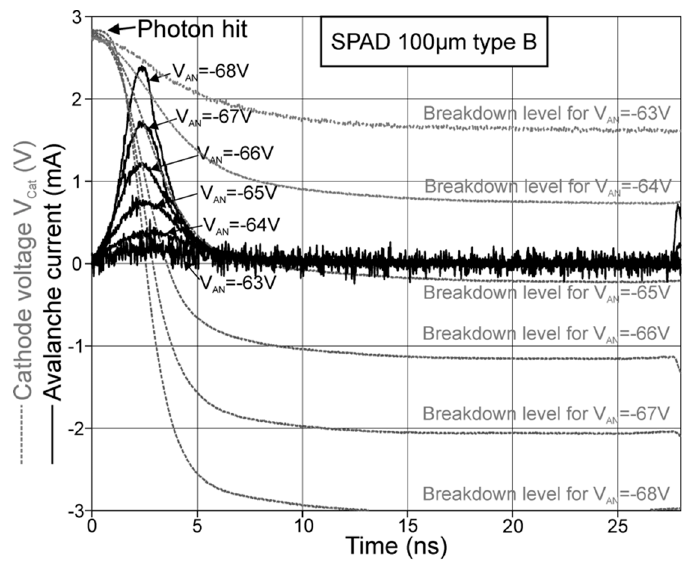
Figure 9. Avalanche-current transients for a SPAD type B with 98.2 µm diameter for different anode voltages V AN , where the avalanche starts at 0 ns. Micromachines 2020 , 11 , x